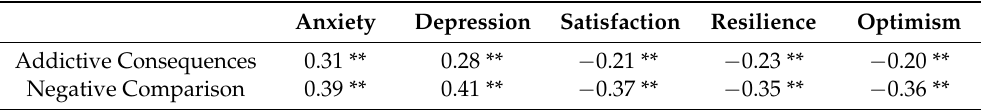
Table 5. Pearson Correlations Between the Social Comparison Subscale, the Addictive Behaviors Subscale, the COVID-Related SNS Use, the HAD Questionnaire, the SWLS Scale, the BRS Scale and the Optimist